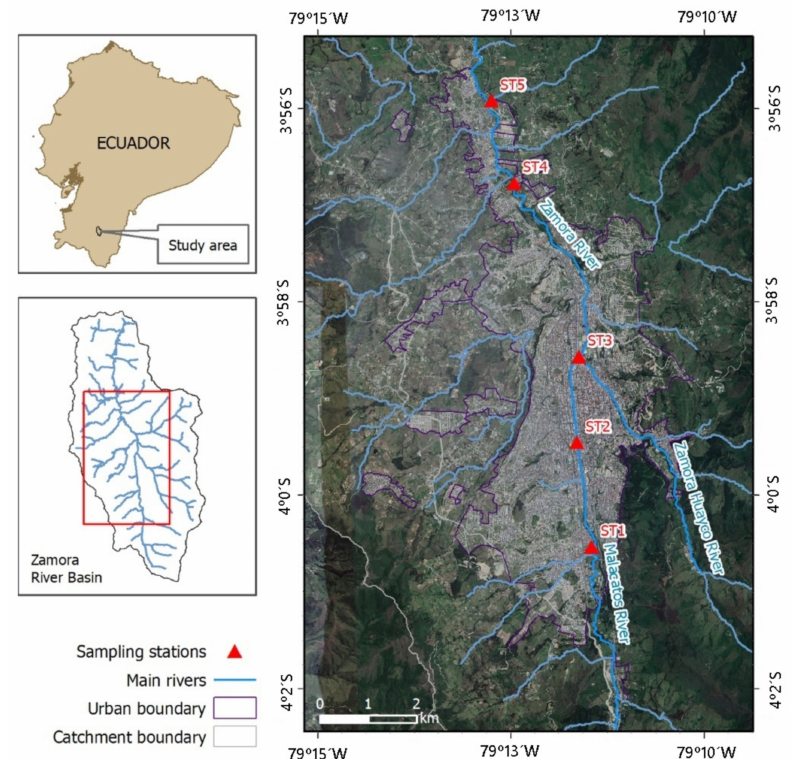
Figure 1. Location of the city of Loja in the upper basin of the Zamora River, its main tributaries, and wastewater discharge sites (ST